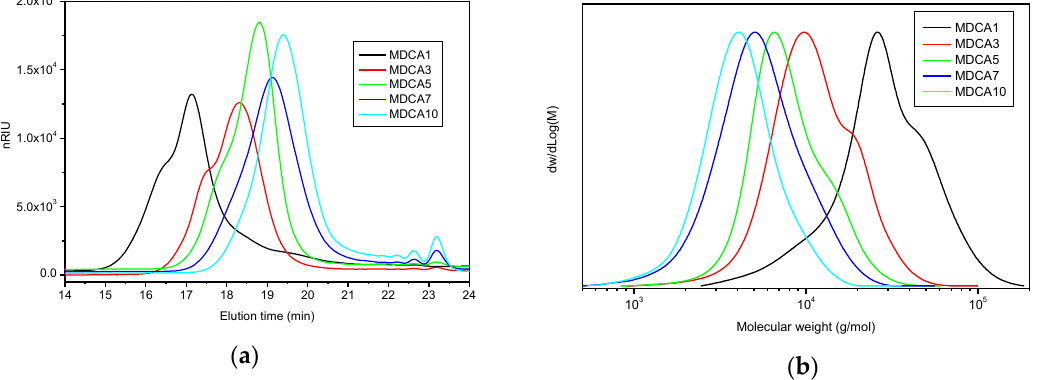
Figure 3. ( a ) Chromatograms collected during size exclusion chromatography (SEC) analysis of MDs